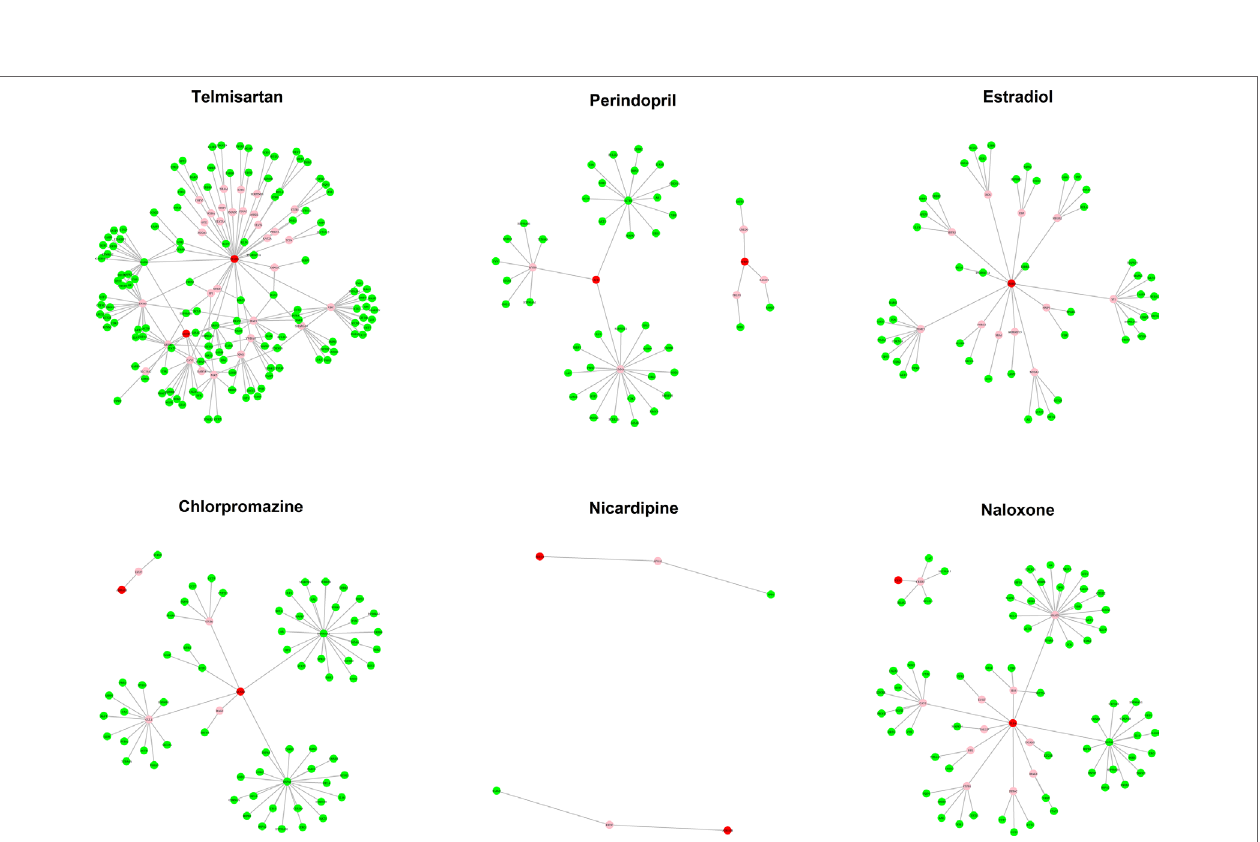
FIGURE 3 | The mode of action (MOA) network of dilated cardiomyopathy (DCM) candidates. Green nodes present known heart failure (HF)-related genes. Red nodes represent drug targets. Pink nodes represent genes with no evidence of corresponding to HF.